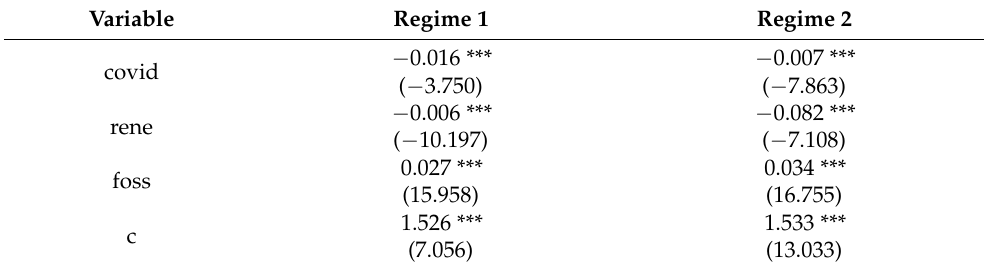
Table 5. Results of robustness test.